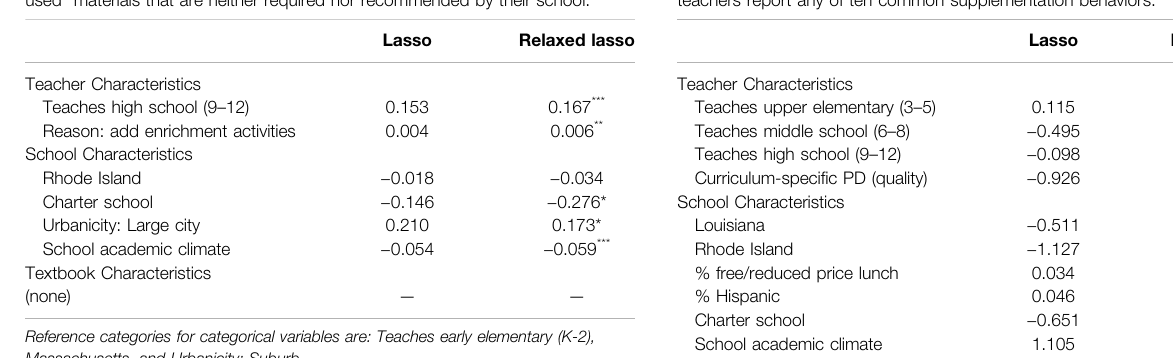
TABLE 3 | Prevalence of supplementation. Proportion of a teacher ’ s “ regularly used ” materials that are neither required nor recommended by their school.